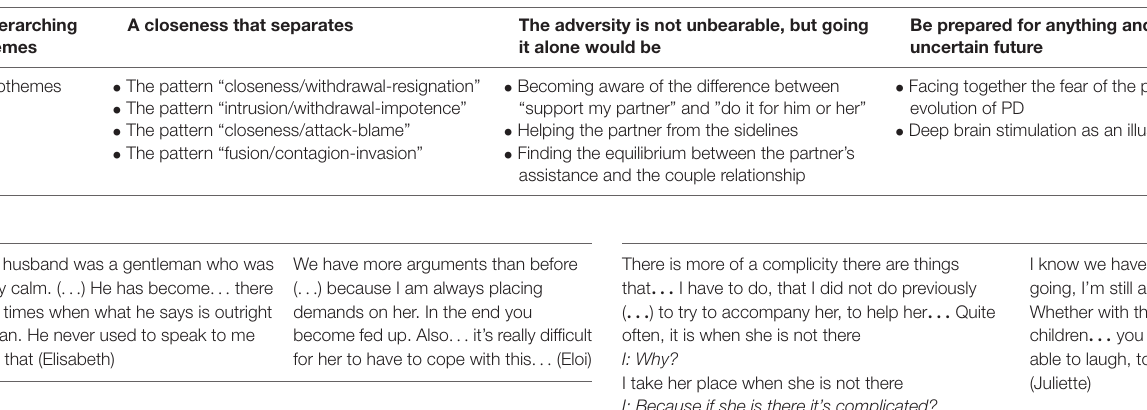
Table 3 | Summary of